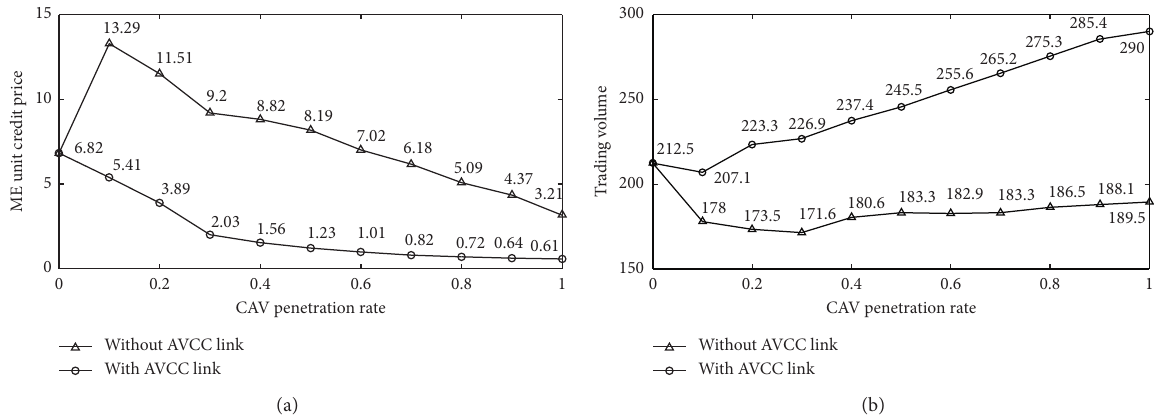
Figure 5: States of credit market under various CAV penetration rates. (a) Market equilibrium unit credit price. (b) Trading volume among